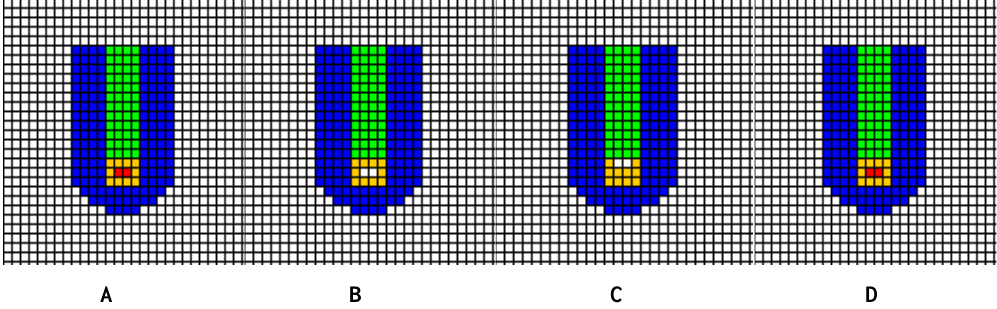
Figure 3: Simulations showing the quiescent center in red, initial stem cells in yellow, transit amplifying cells in green and differentiated cells in